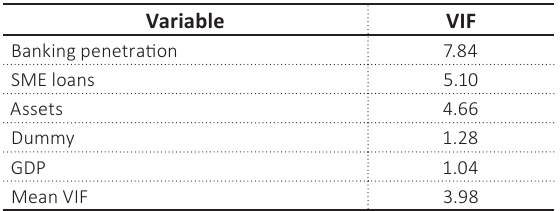
Table 4. Variance inflation factor